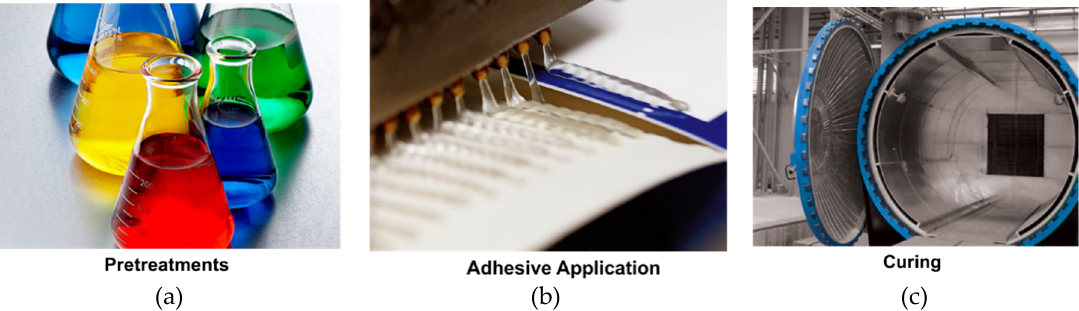
Figure 1. Main phases used in the adhesive binding process. ( a ) Pretreatments, ( b ) Adhesive Application, ( c ) Curing.